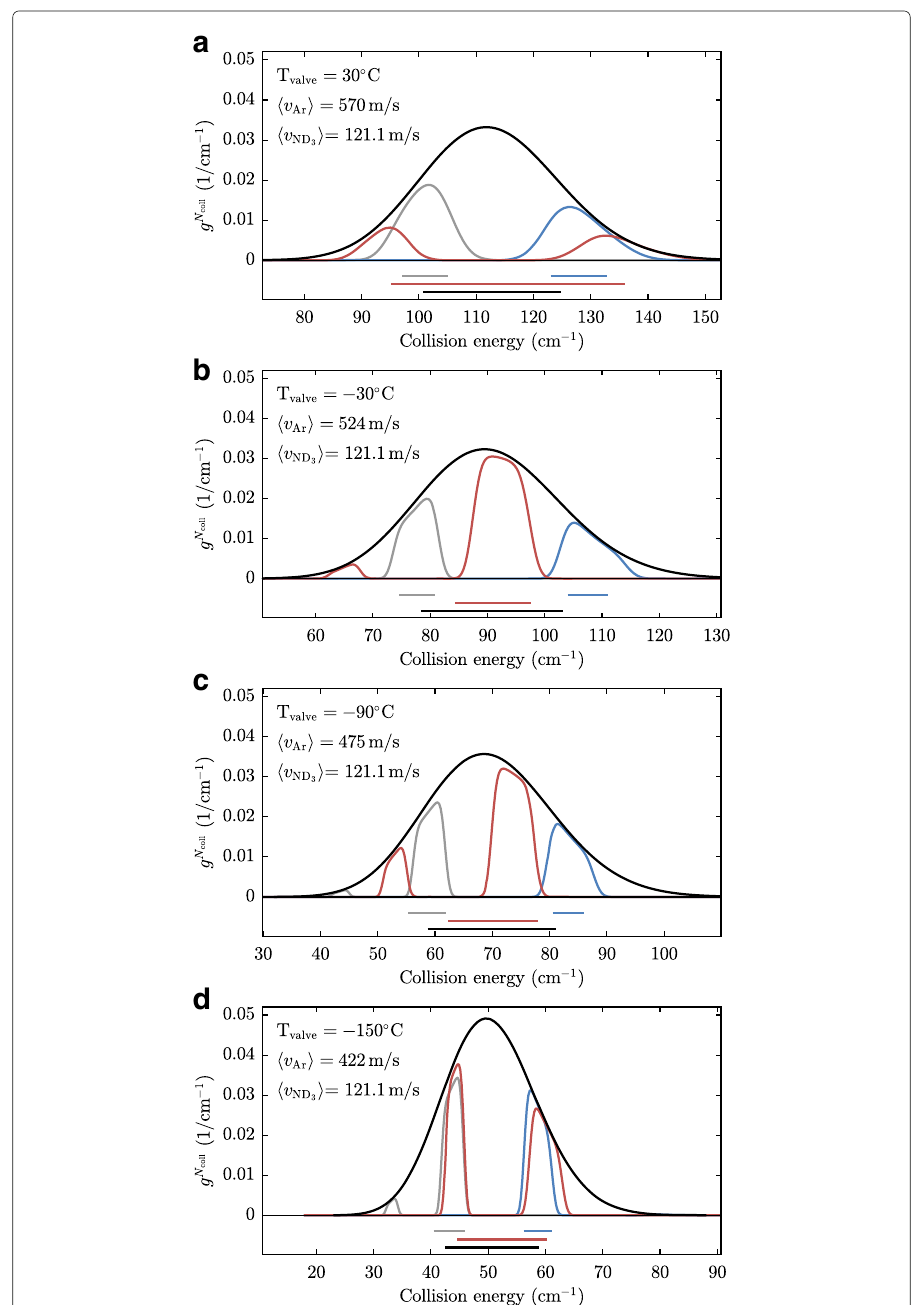
Fig. 14 a - d Collision energy distributions determined from simulations for collision experiments with = 121.1m/s and v v ND Ar as indicated. The black curves represent the distribution for collision measurements 3 that combine the measurements at each valve timing, i.e. all the black squares in Figs. 12 and 13. Since in this way the entire argon packet is probed, the distribution corresponds simply to the longitudinal velocity distribution of the argon beam at a particular temperature. The grey, red, and blue curves represent the collision energy distributions for the collision measurements indicated by the grey, red, and blue data points in Figs. 12 and 13. The grey, red, blue, and black bars in the bottom of each graph represent the widths of the distributions, as they are displayed by the horizontal error bars in Fig.